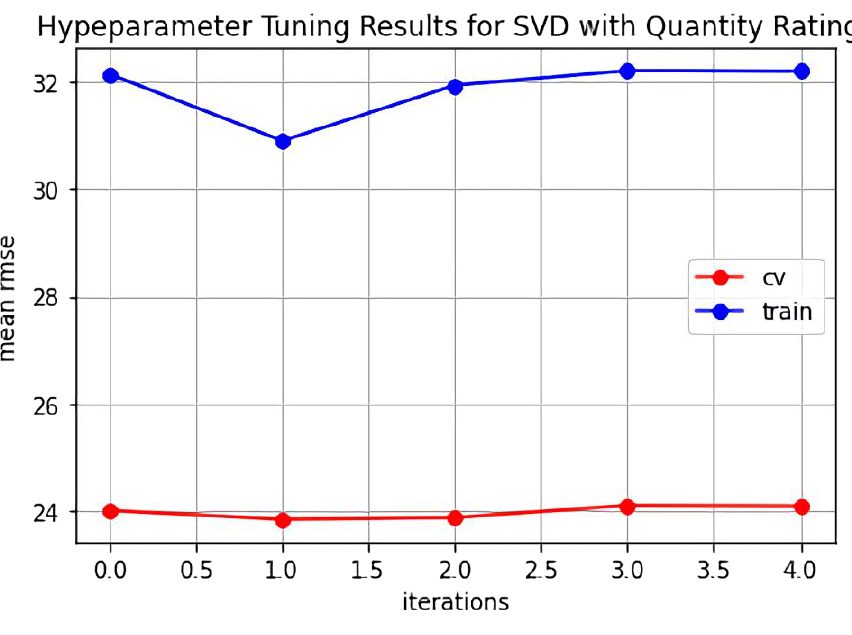
Figure 6. Hyperparameter tuning for SVD with